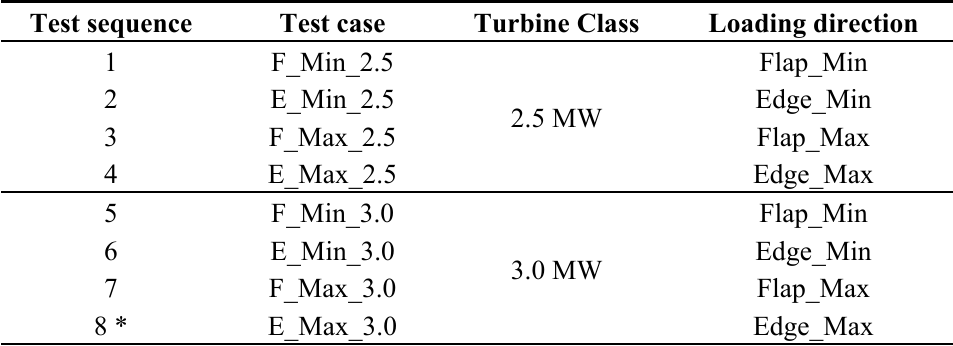
Table 1. Load test history of the